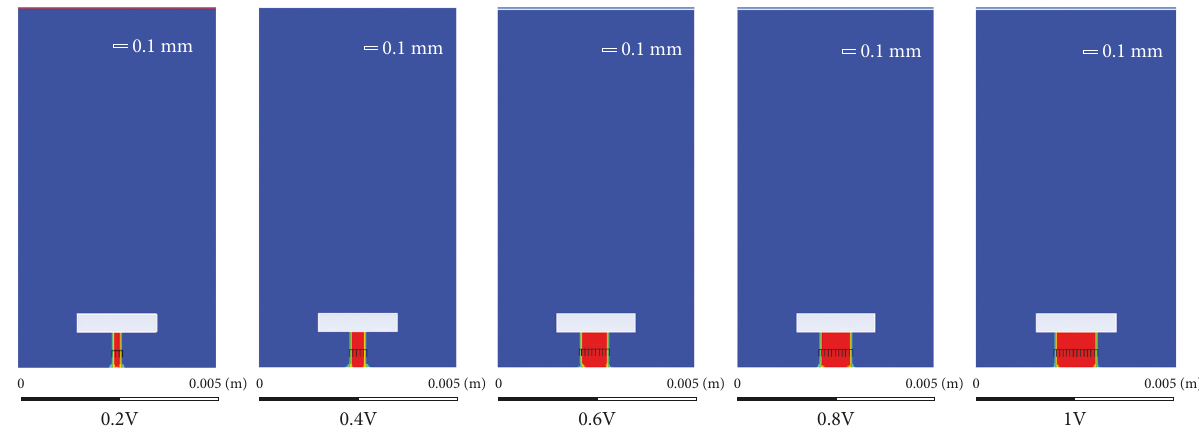
Figure 13: Numerical simulation nephogram of different initial ink volumes.